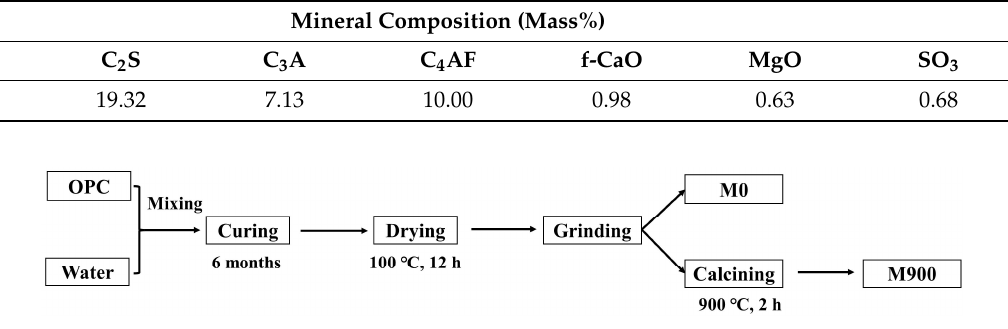
Figure 1. Flowchart of preparing simulated waste cement.